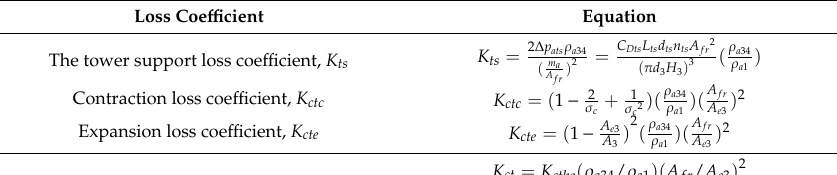
Table 2. The coefficients of loss of air in NDDCT [33].